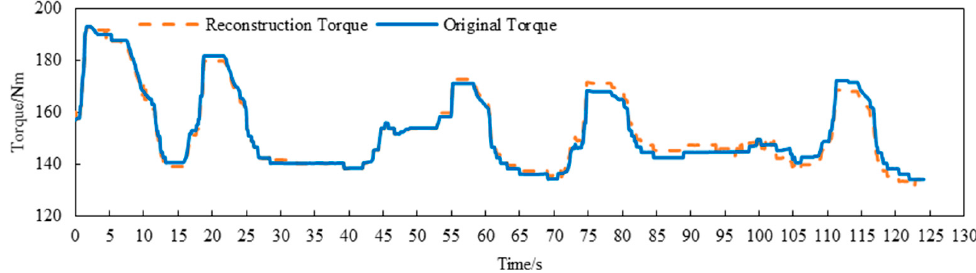
Figure 18. Comparison between reconstructed load and original data.